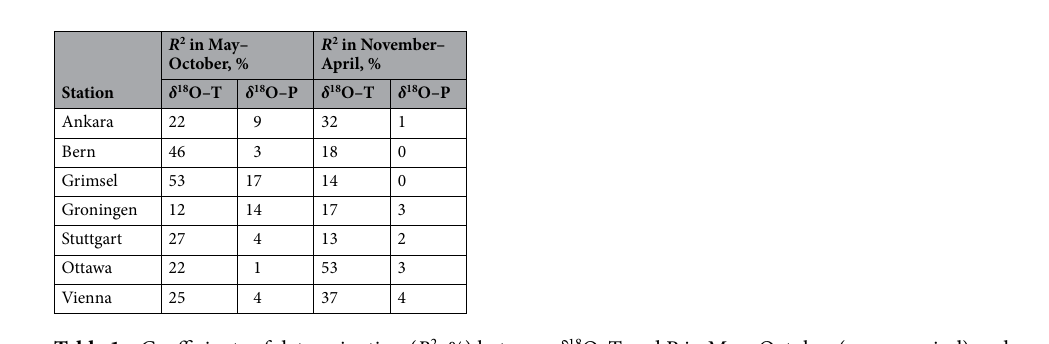
Table 1. Coefficients of determination ( R 2 , %) between δ 18 O, T and P in May–October (warm period) and November–April (cold